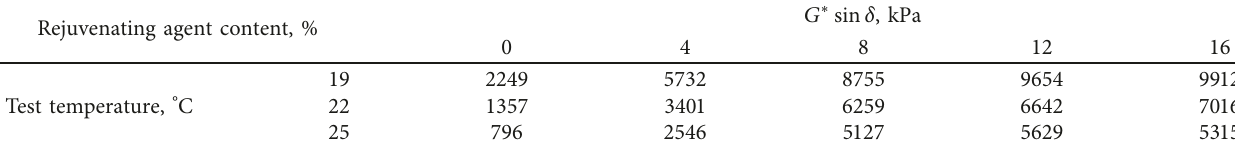
Table 11: Test results of G ∗ sin δ